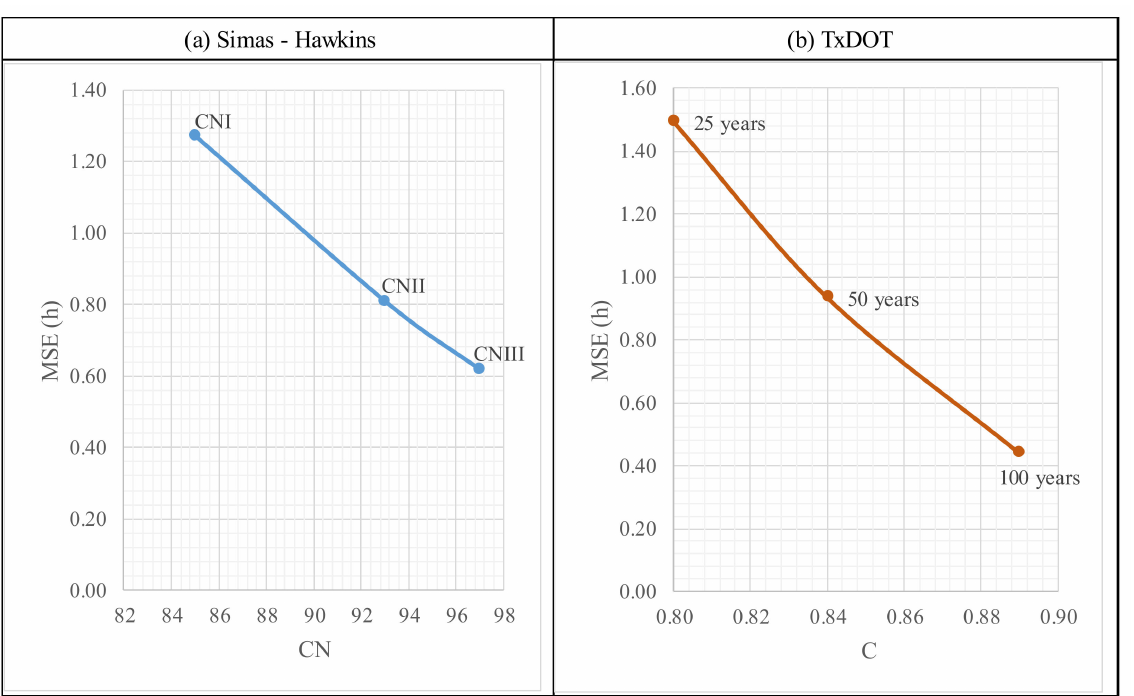
Figure 8. Calculation of MSE changing CN and C: ( a ) Simas-Hawkins; and ( b )